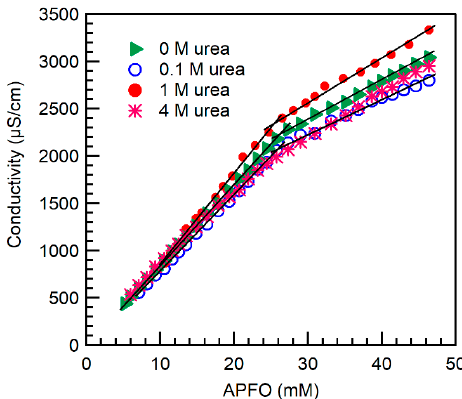
Figure 1. Conductivity of ammonium perfluorooctanoate (APFO) aqueous solutions plotted versus surfactant concentration in the absence and in the presence of added urea at various concentrations (shown inside the graph) (24 °C). Linear fits to the data points below and above the break point have been applied in order to determine the critical micelle concentration (CMC). Table 1. CMC and degree of counterion dissociation ( α ) of APFO, lithium perfluorononanoate (LiPFN), lithium perfluorooctane sulfonate (LiPFOS), and sodium dodecyl sulfate (SDS) in aqueous solution, in the absence and in the presence of added urea. The data for APFO and SDS were determined in the present study, and compared with LiPFN, LiPFOS, and SDS data from the literature [24,27,28,50,51].